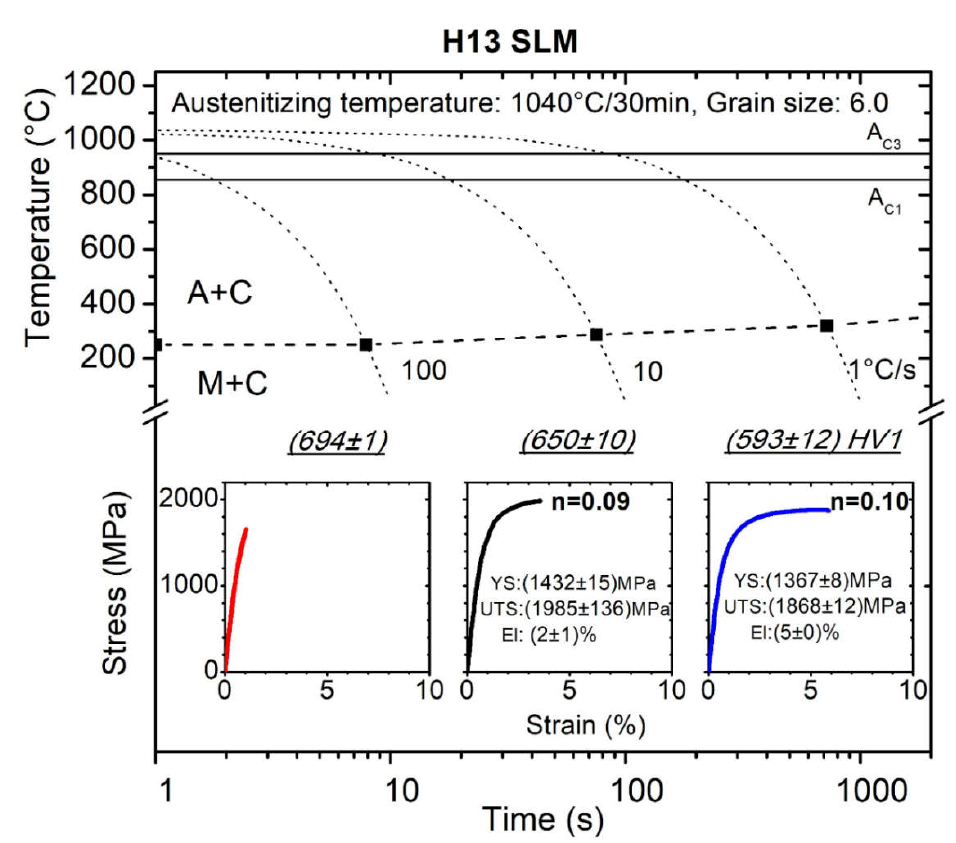
Figure 5. CCT diagram for SLM prepared H13 (A + C: austenite + carbide, M + C: martensite + carbide).